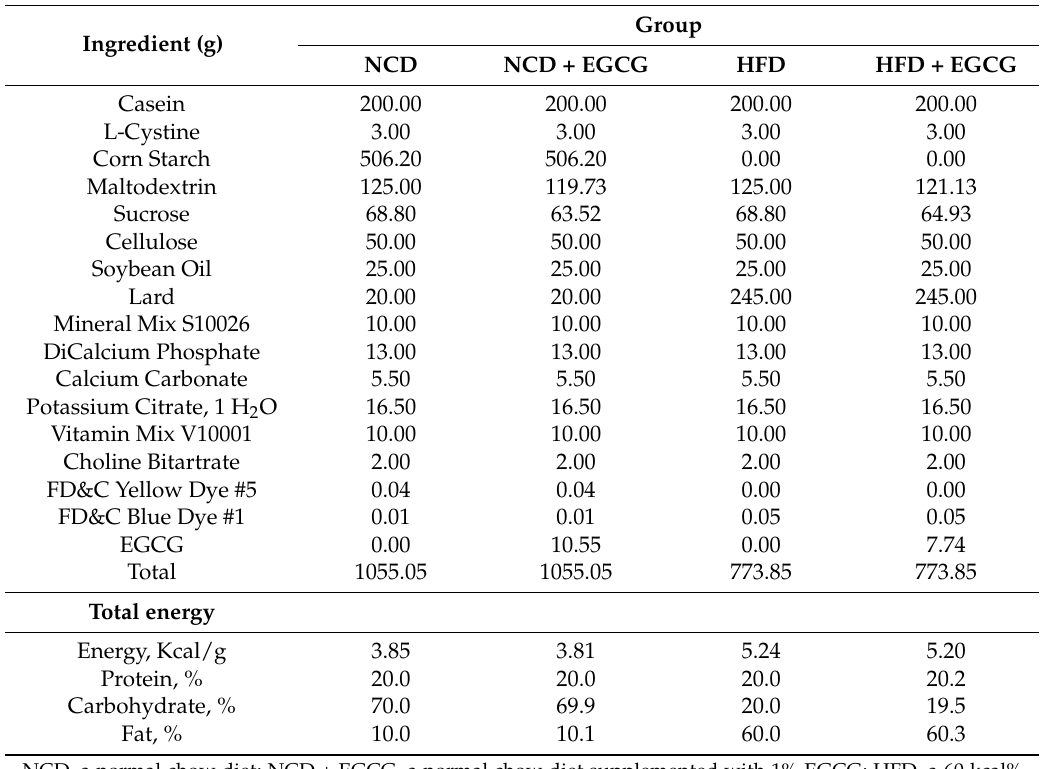
Table 1. Compositions of experimental